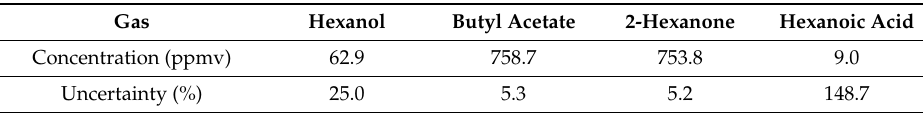
Table 2. Gaseous volatile organic compound (VOC) concentrations at 100% concentration and the uncertainty